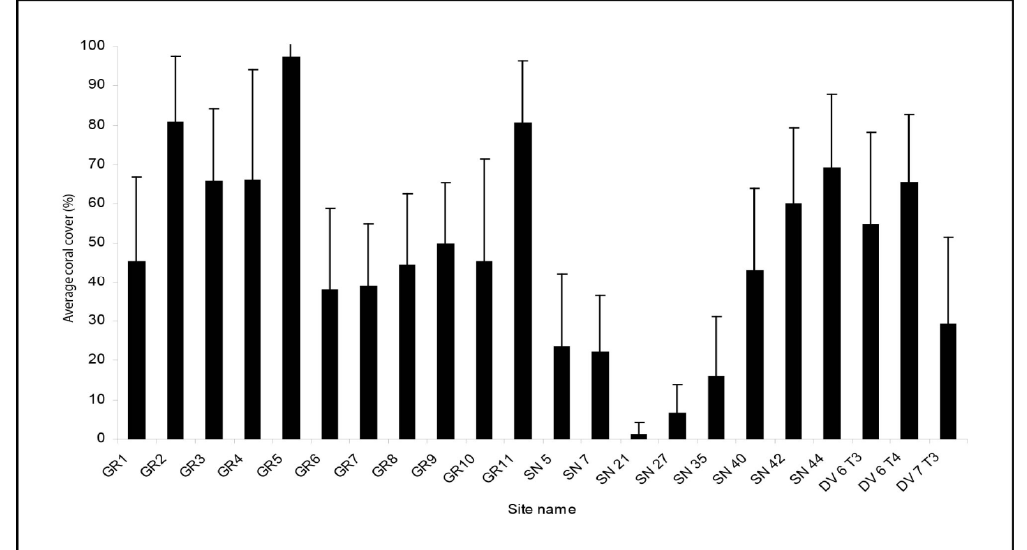
Figure 5. Average coral cover based on field survey of the sites used for index calibration. Bars indicate standard deviation. Site name prefixed by GR denotes a grid calibration site; SN denotes a snorkel calibration site; and DV denotes a dive transect calibration site. See Figure 1 for location of grid, snorkel and dive transect calibration